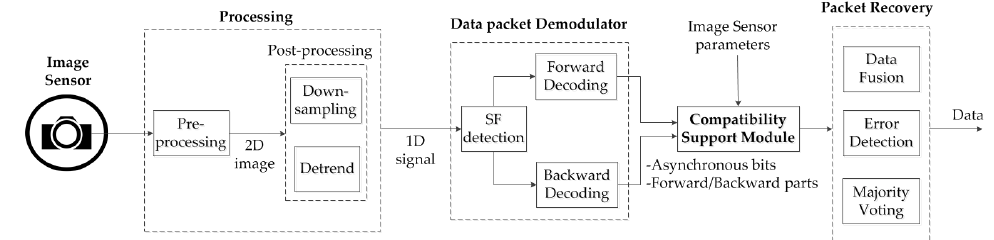
Figure 8. Asynchronous decoding procedure using asynchronous bits.